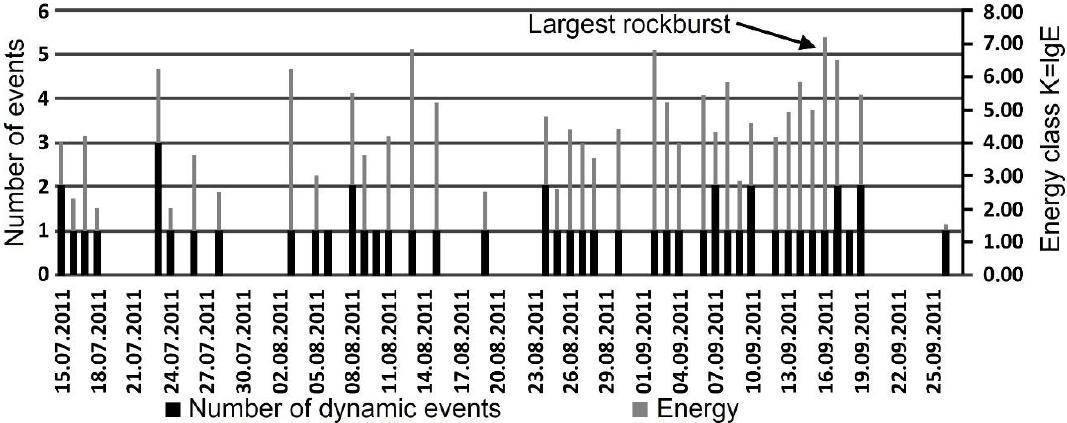
Figure 3. Dynamics of seismic activity due to panel 1 stope advancement in study site over ≈ 70 days. Arrow points out the largest rock burst.